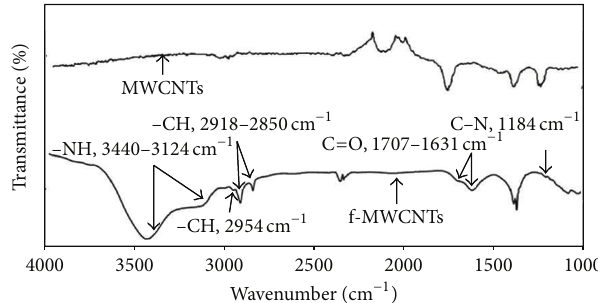
Figure 2: FTIR spectra of raw MWCNTs and f-MWCNTs.